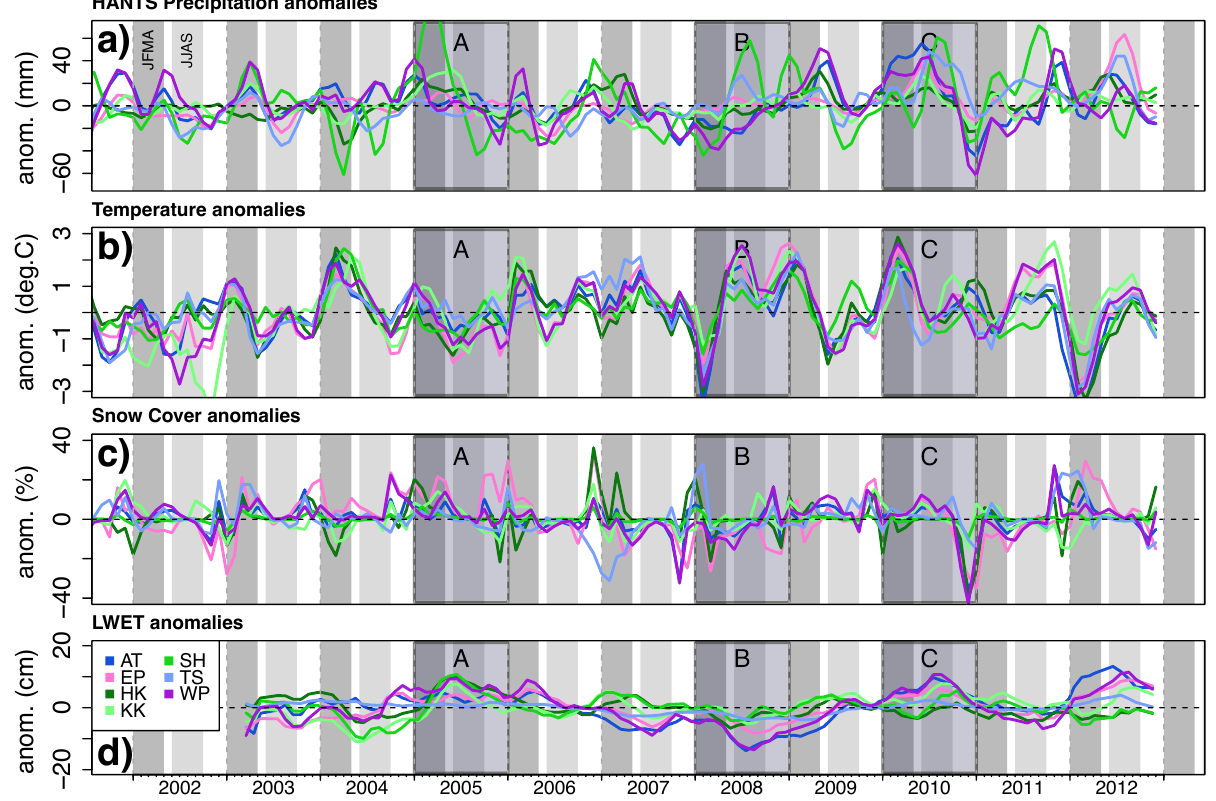
Figure 6. Monthly meteorological anomalies for ( a ) HANTS precipitation, ( b ) temperature, ( c ) snow cover and ( d ) liquid water equivalent thickness (LWET). The running mean of three months is applied for clearer visualization. Capital letters A, B and C are the three individual years that are analyzed in detail to point out the interplay between meteorological parameters. Vertical dark grey bars denote the winter (JFMA; January–April) and light grey bars the summer (JJAS; June–September)